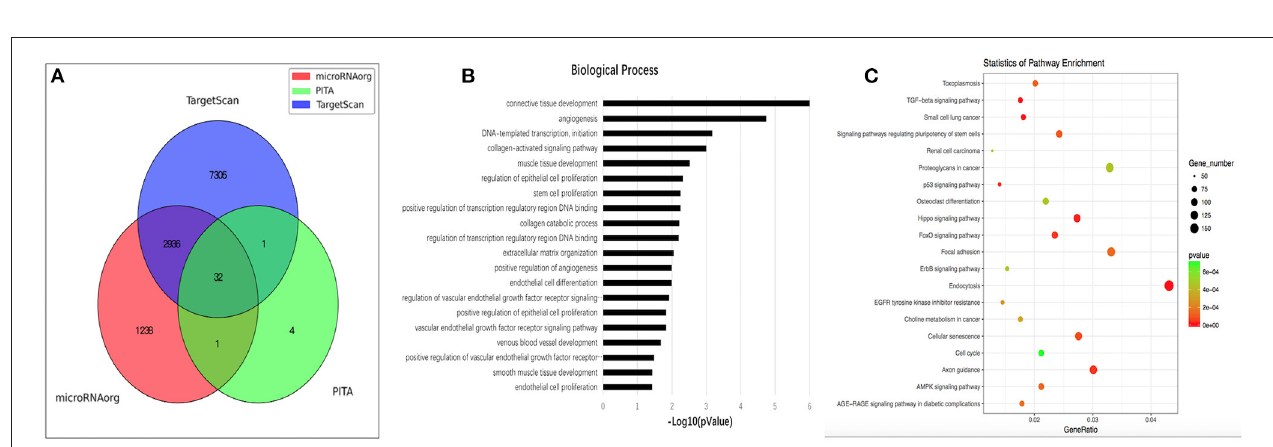
FIGURE 3 | Relative expression levels of five miRNAs between aSAH patients and controls in the validation stage. (A) miR-23b-3p; (B) miR-590b-5p; (C) miR-20b-5p; (D) miR-142b-3p; (E) miR-29b-3p. Relative expression levels were all significantly lower in aSAH patients than in controls (all P < 0.05). miRNAs indicate microRNAs and aSAH, aneurysmal subarachnoid hemorrhage.